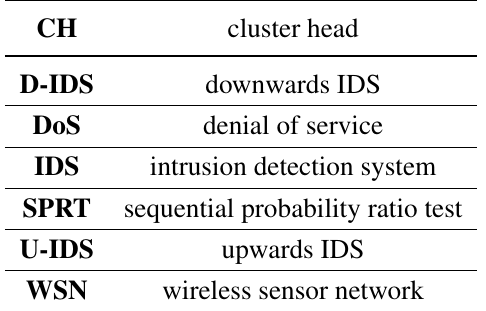
Table A1. List of